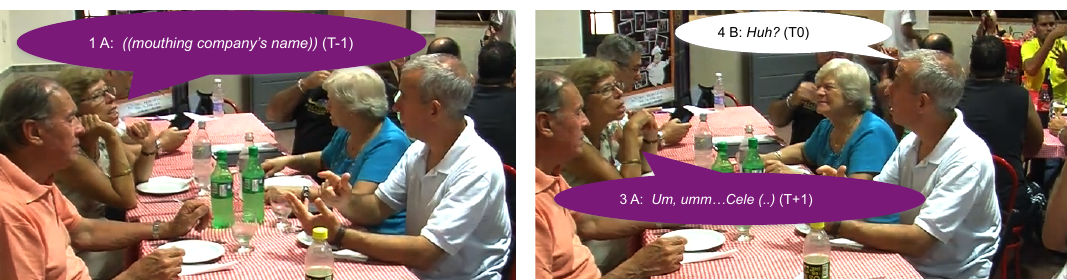
Figure 14. ‘Huh?’ , Person B, on the right of the arrow, initia- tes repair on Person A’s previous turn by opening his mouth and lifting his head up, line 2